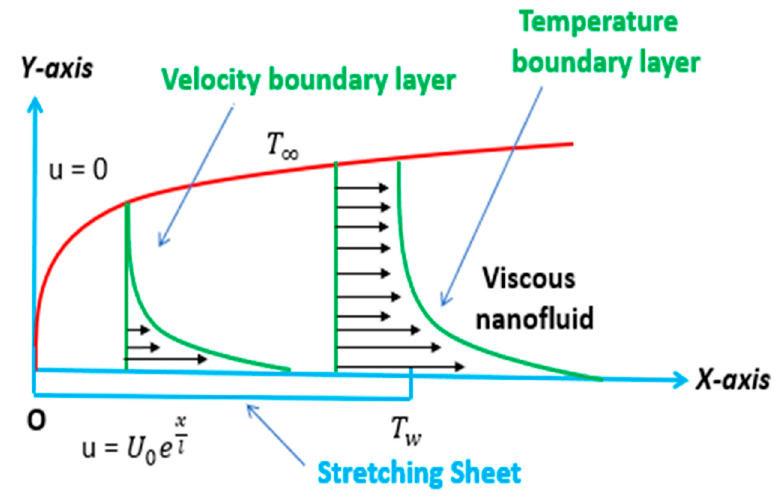
Figure 1. Physical diagram of the present flow